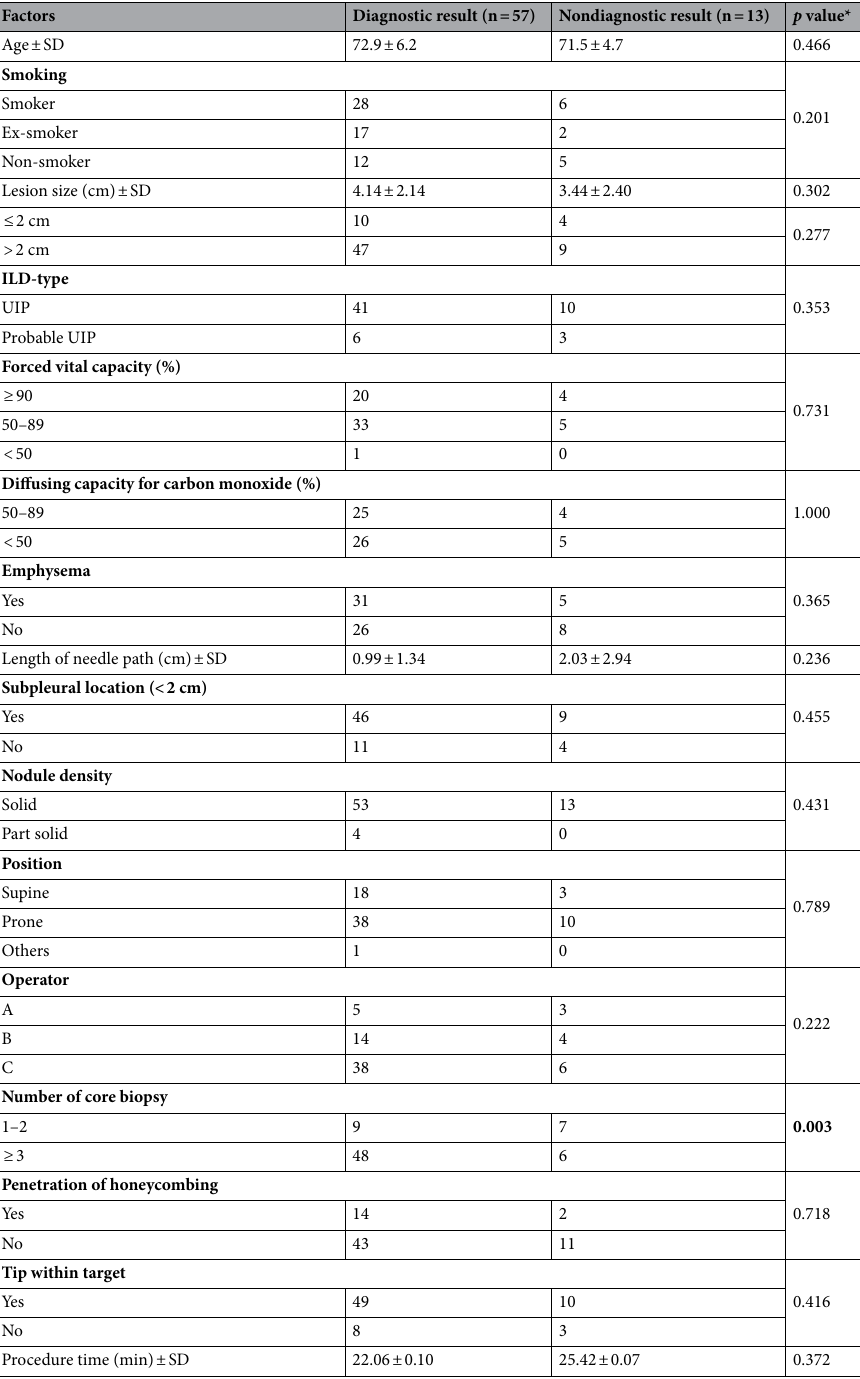
Table 3. Risk factors for nondiagnostic results. * p value of Pearson χ 2 test or Fisher’s exact test for categorical variables and Student’s t-test for continuous variables. SD standard deviation. Significant values are in